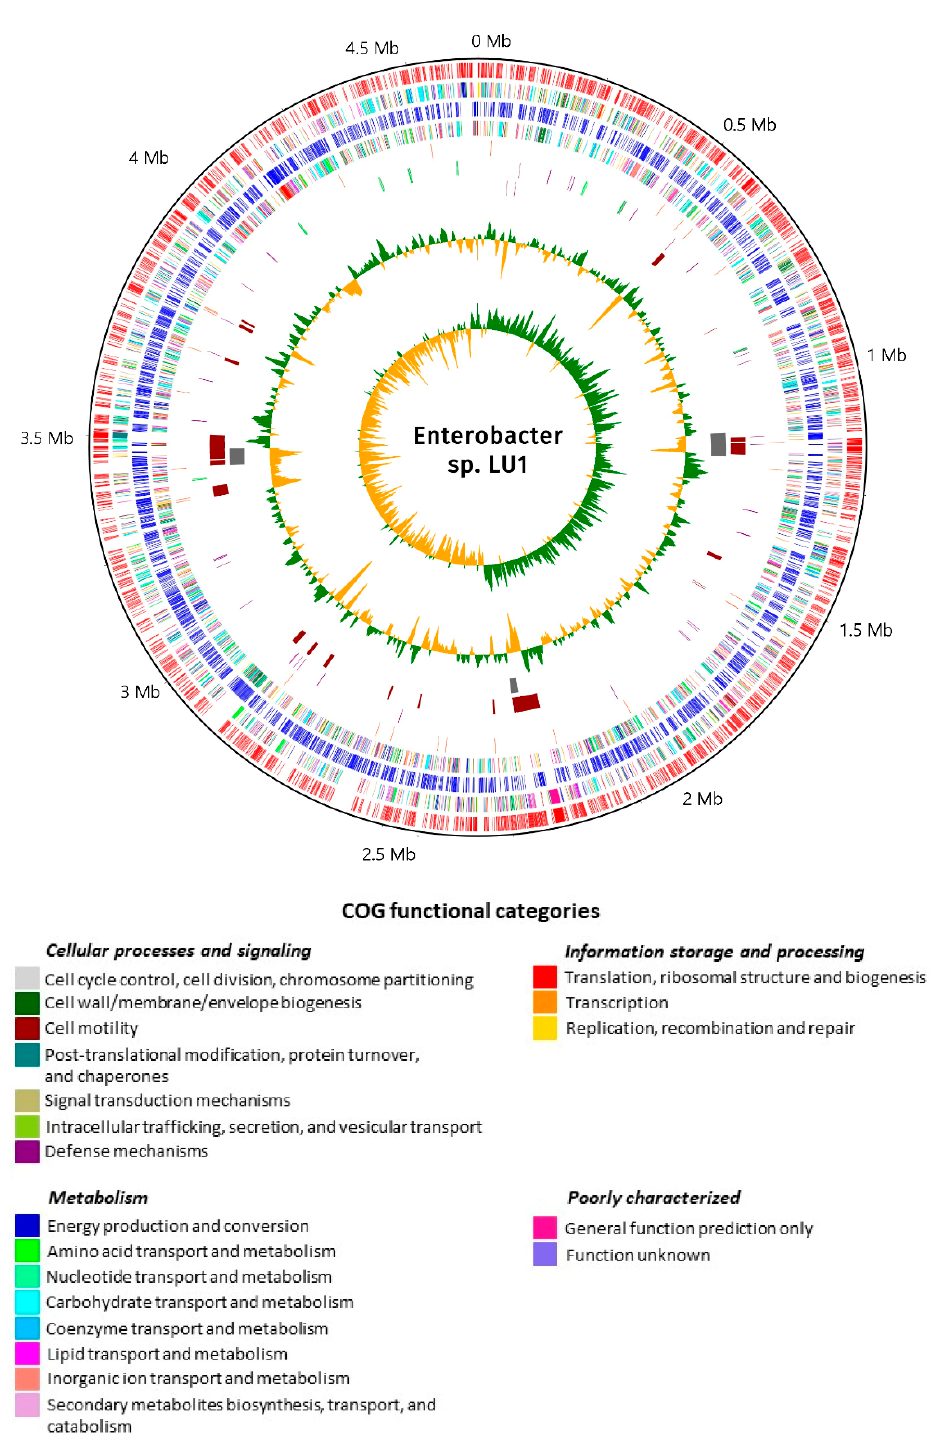
Figure 2. Circular map of Enterobacter sp. LU1 genome. From the outer to the inner circle, representation is as follows: 1: position in megabases (black); 2: forward strand coding sequences (CDSs) (red); 3: forward strand clusters of orthologous groups (COGs) (legend); 4: reverse strand CDSs (blue); 5: reverse strand COGs (legend); 6: pseudogenes (dark orange); 7: ribosomal RNAs (rRNAs) (lime) and transfer RNAs (tRNAs) (purple); 8: horizontal gene transfer (HGT) regions (dark red); 9: phage sequences (gray); 10: GC content (green and orange correspond to higher and lower than average content, respectively); 11: GC skew (green and orange correspond to higher and lower than average skew, respectively). Whole-genome sequence visualization was performed using CGView software [33]